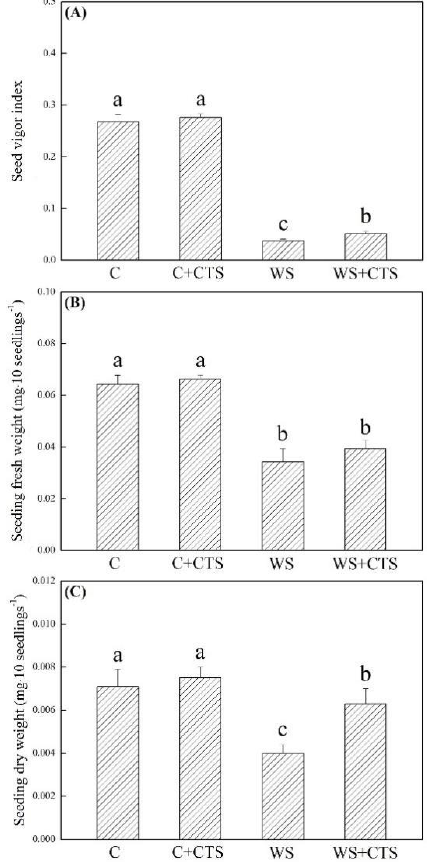
Figure 2. Seed priming with chitosan affected ( A ) seed vigor index, ( B ) seedling fresh weight, and ( C ) seedling dry weight after 7 days of germination under water stress. Vertical bars above columns indicate ± SE of mean, and different letters above columns indicate significant difference ( p < 0.05). C, control (seeds pretreated with H 2 O germinated under normal condition); C+CTS, control + CTS (seeds pretreated with CTS germinated under normal condition); WS, water stress (seeds pretreated with H 2 O germinated under water stress condition); WS+CTS, water stress + CTS (seeds pretreated with CTS germinated under water stress condition).